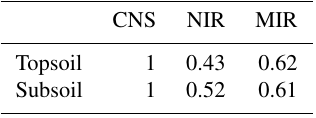
Table 1. Layers used in the sequential model built for topsoil and subsoil TC prediction.